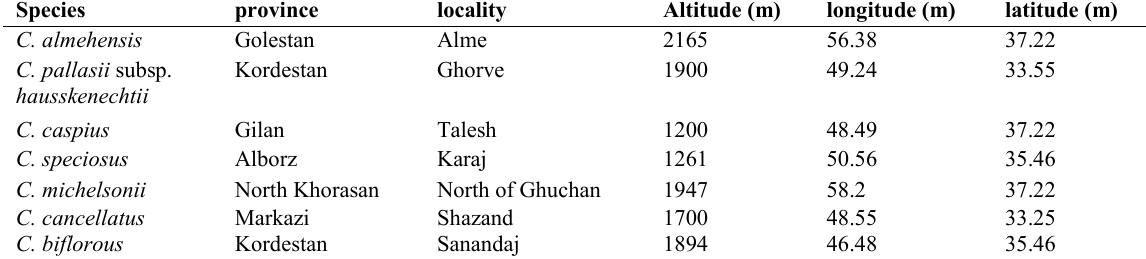
Table 1. Samples collection